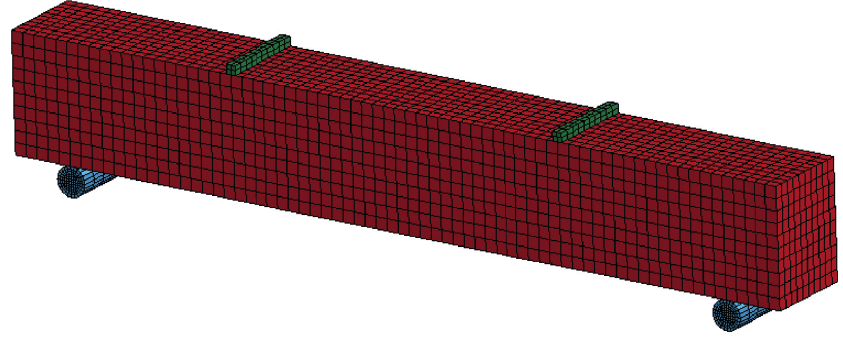
Figure 10: Finite element model of the simplified reinforced concrete simply supported beam.